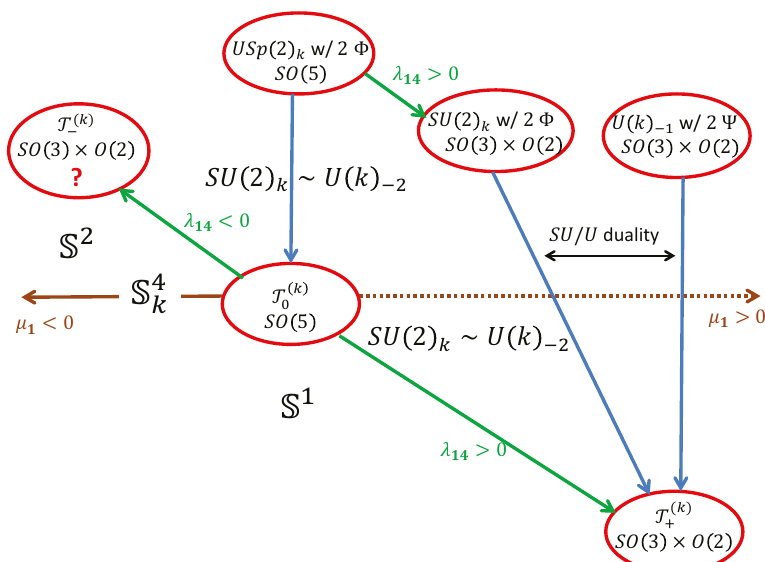
Figure 2 . RG diagram and (cid:12)xed points of SU(2) k with two scalars. The blue and brown lines are RG (cid:13)ows that preserve the global symmetry of the UV (cid:12)xed point they emanate from. The green lines are deformations that break the SO(5) global symmetry. The solid green and brown lines separate between phases with di(cid:11)erent IR behavior ( S 1 , S 2 , and gapped with a TQFT), with an S 4 theory (with a Wess-Zumino term with coe(cid:14)cient k ) along the brown solid line. There is no phase transition along the dotted brown line, as the IR physics is gapped